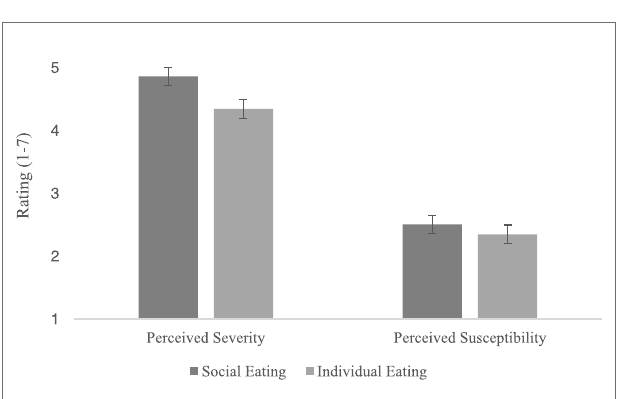
FIGURE 2 | Perceived severity of and susceptibility to threat ratings as a function of type of social eating cues present in the obesity PSA